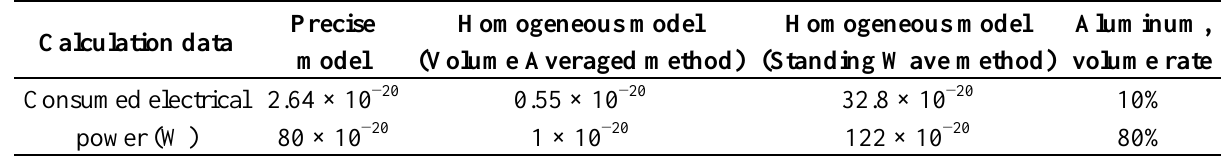
Table 8. Consumed electrical power in the precise model and homogeneous